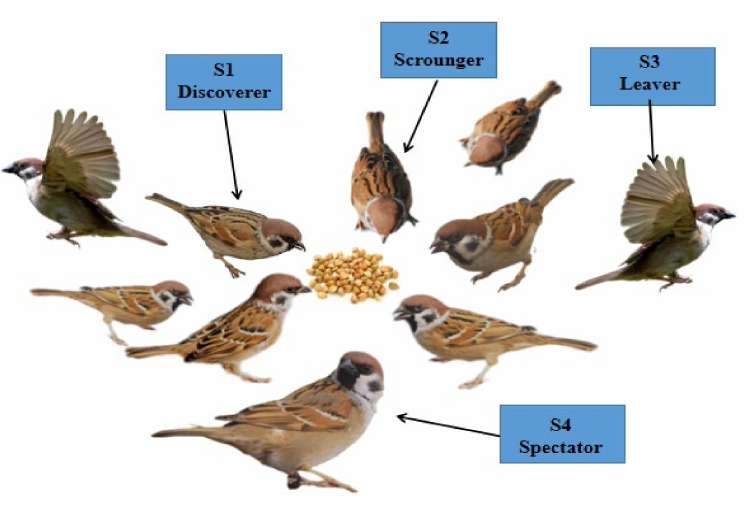
Figure 5. Interrelationships between individuals in the sparrow